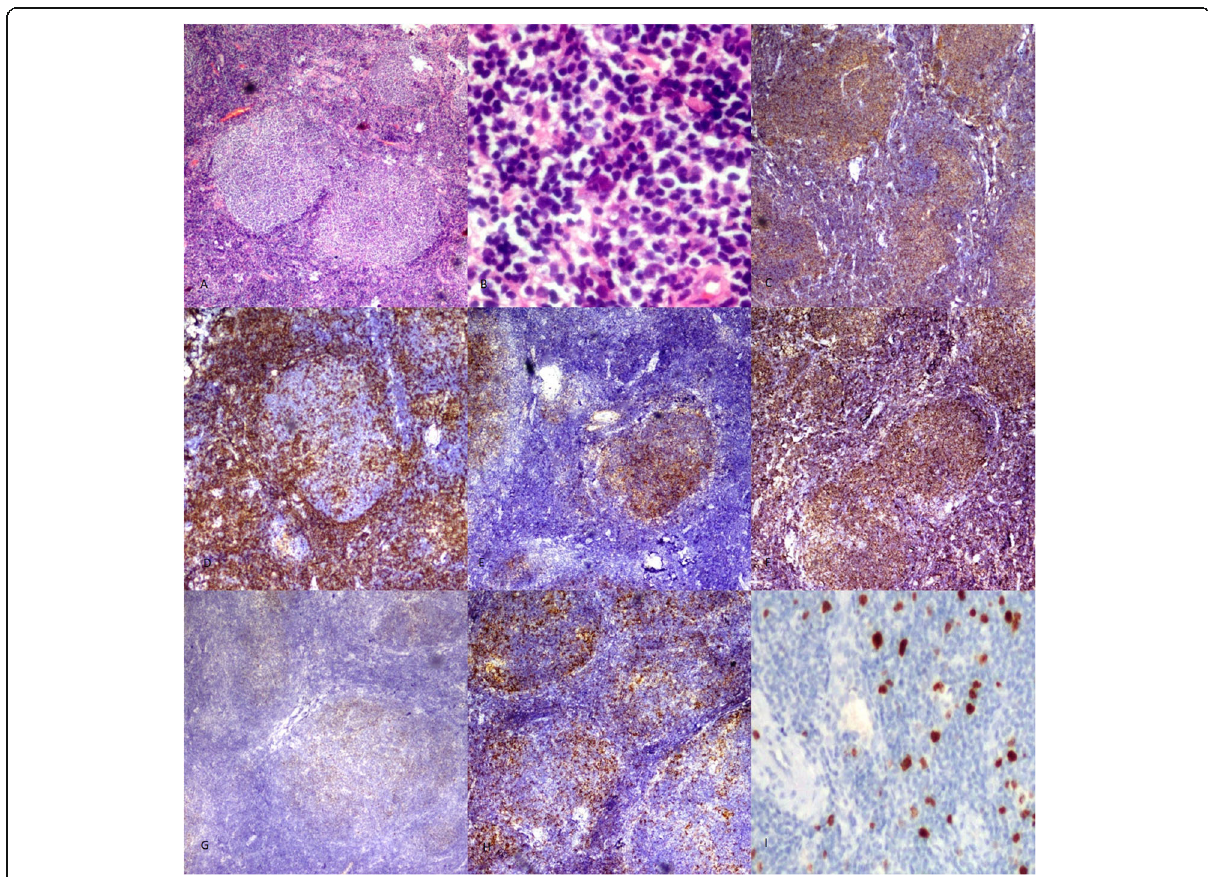
Fig. 3 Histopathology images of biopsy specimen done in 2018 suggestive of follicular lymphoma. a 40× lymph node displaying uniform follicles arranged back to back. b 400× the atypical lymphoid cells show cleaved nucleus, scant cytoplasm. No centroblasts present. c 40× CD 20 positive. d 40× CD 3 negative. e 40× CD 10 positive in the follicular cells and faintly in the interfollicular region. f 40× Bcl2 positive. g 40× Bcl6 positive. h 100× CD 23 positive follicular dendritic cells in the stromal meshwork. i 100× Ki-67 Proliferation Index was 15 to